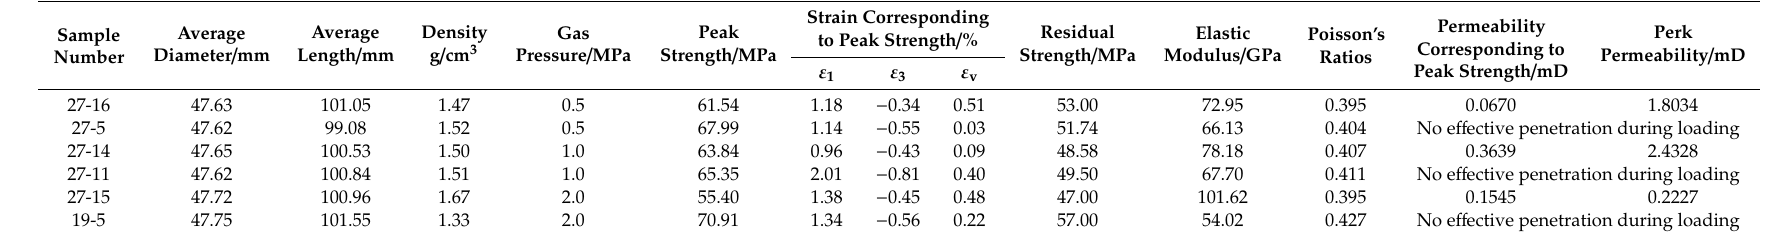
Table 3. Basic information and test results of coal samples under CTC